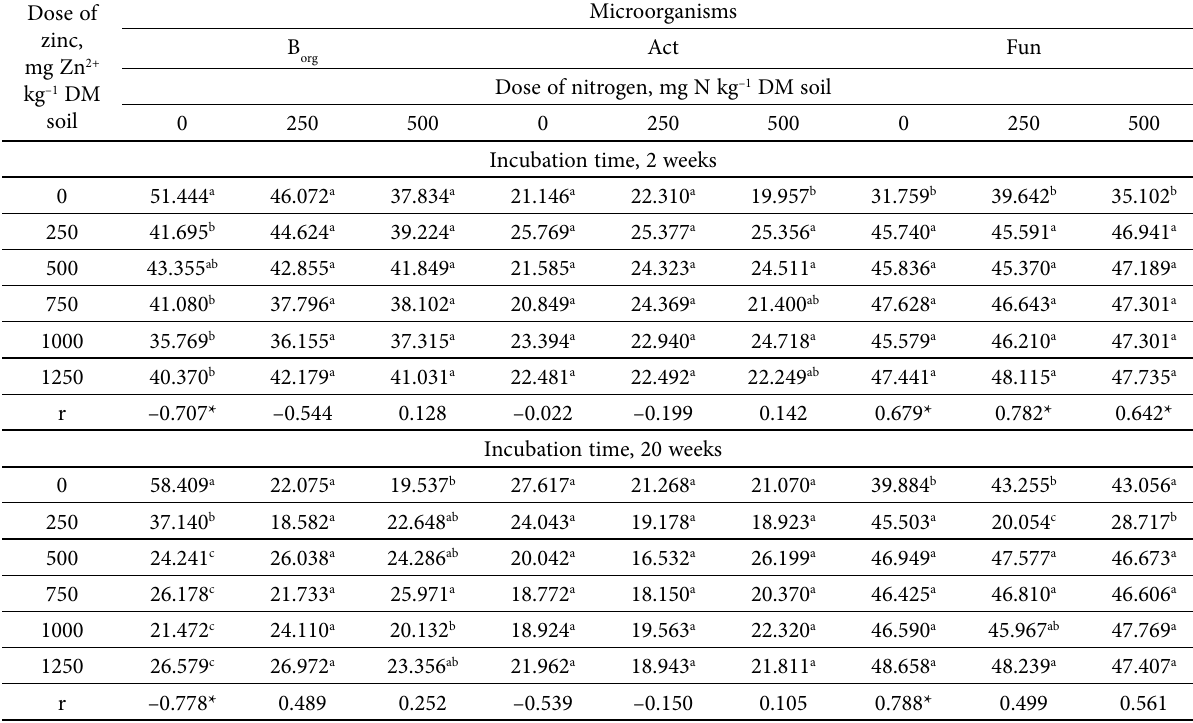
Table 2. Colony development (CD) index for microorganisms in the soil contaminated with zinc (the values are means of three replicates)